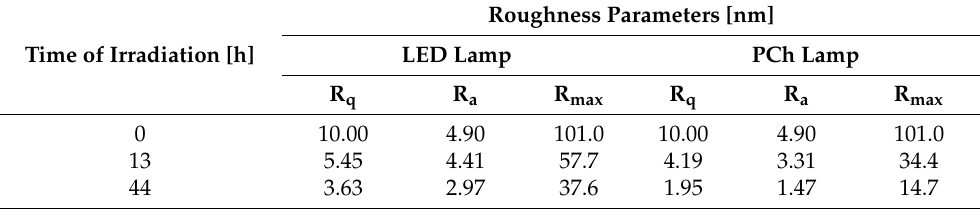
Table 1. Roughness parameters (R q , R a , and, R max , nm) of levan films before and after